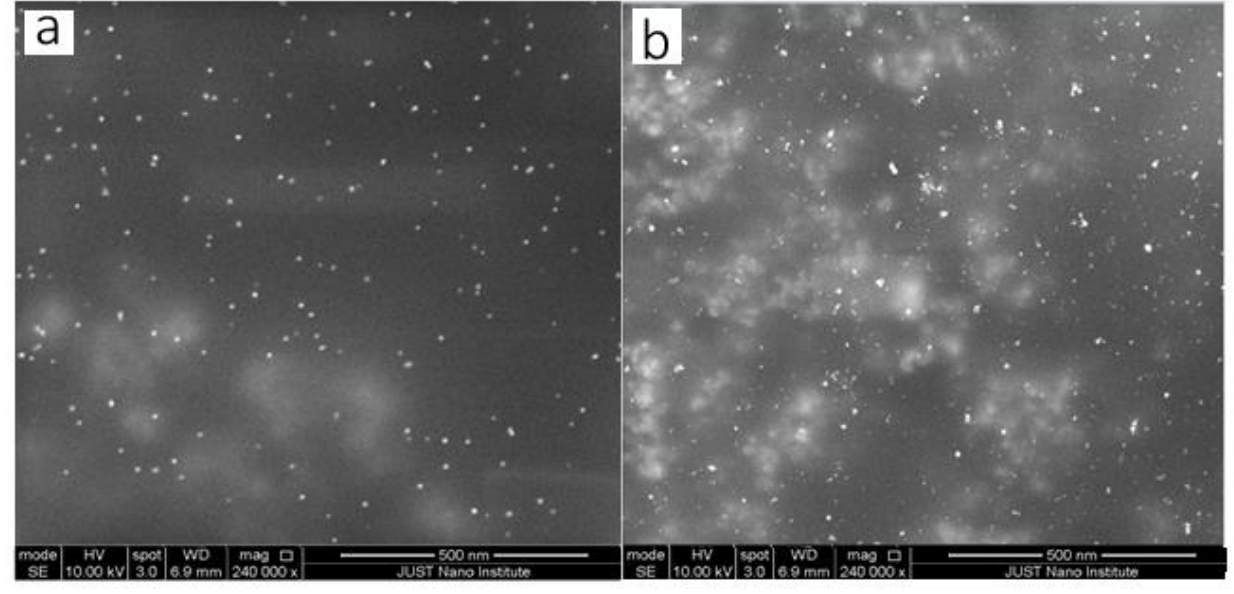
Figure 14 . SEM images of the GNPs prepared at different temperature. ( a ) at high temperature (328.15 K), ( b ) at room temperature (291.15 K).